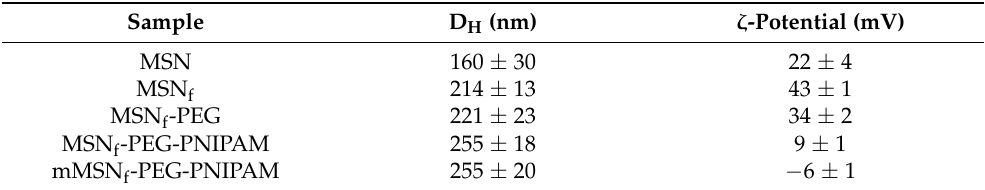
Table 1. Characteristics of the different MSNs synthesized in this work obtained by DLS and ζ -potential (data are mean ± SD of the five